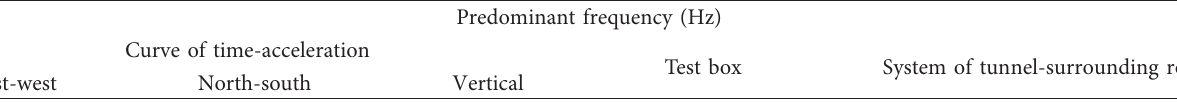
Table 5: Dynamic characteristics.